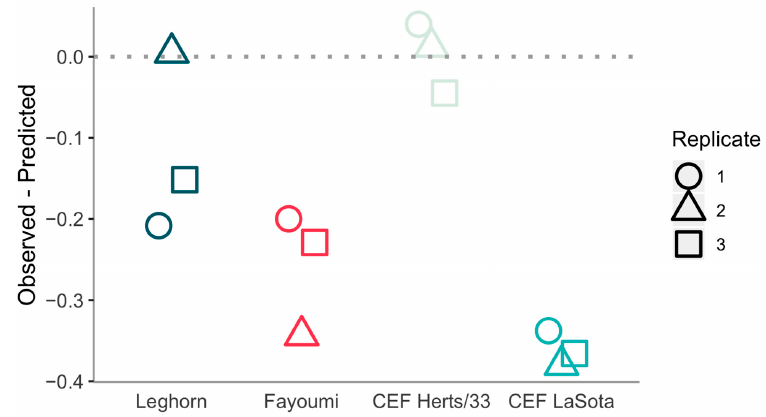
Figure 5. Difference between the actual log10-fraction of reads with +GG insertions and the predicted Figure 5. Di ff erence between the actual log10-fraction of reads with + GG insertions and the predicted one based on our model fitted on all but +GG insertions. one based on our model fitted on all but + GG